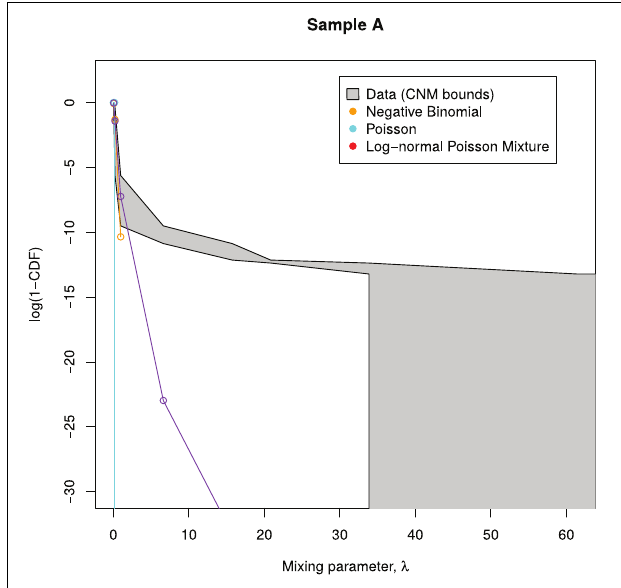
FIGURE 3 | Candidate mixing distributions, and their consistency with the CNM-derived mixing distribution. For clarity, we plot log(1 − CDF ) where CDF is the Cumulative Density Function of (cid:3) , and values are calculated only at CNM’s λ support points. A mixing distribution that is consistent with CNM’s predicted mixing distribution, as derived in Section 3.2, would have a line contained within the shaded region, with the black lines representing upper and lower bounds. Here, the lines do not stay within the bounds, indicating that all of the models deviate from CNM’s